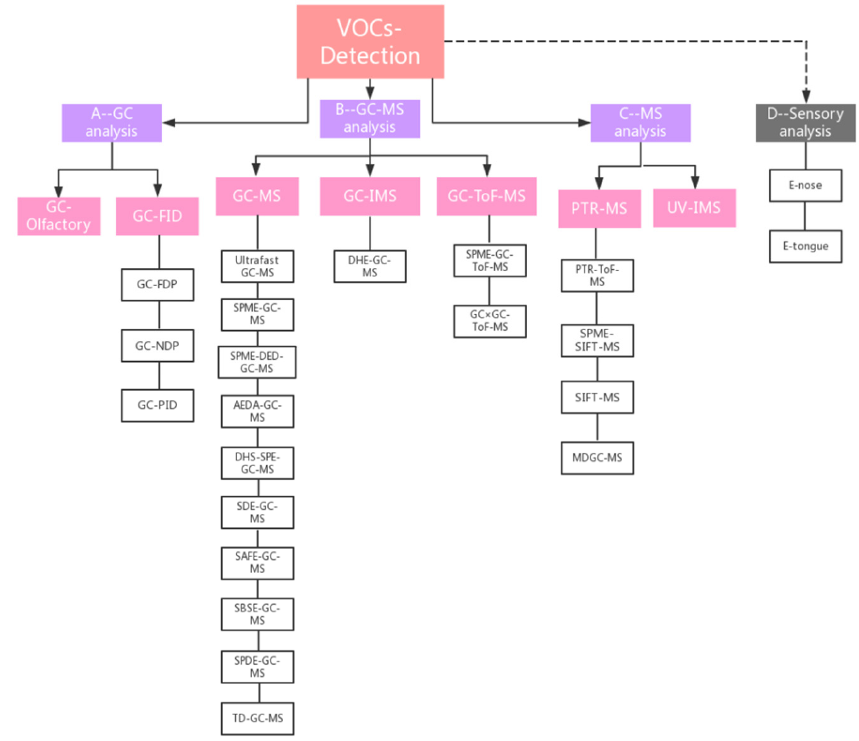
Figure 5. Classification of the instruments/methodologies used for VOC analysis.